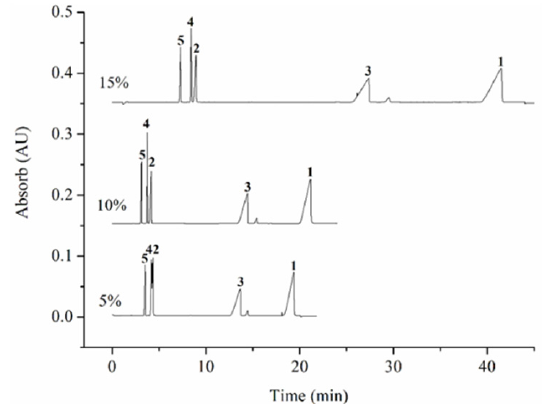
Figure 3. Electropherograms of five compounds at different concentration of methanol in buffer. Running buffer: 10 mM sodium dodecyl sulfate and 50 mM sodium borax-sodium dihydrogen phosphate system (pH = 8.5). Separation voltage: 30 kV. Other conditions are the same as Figure 2.